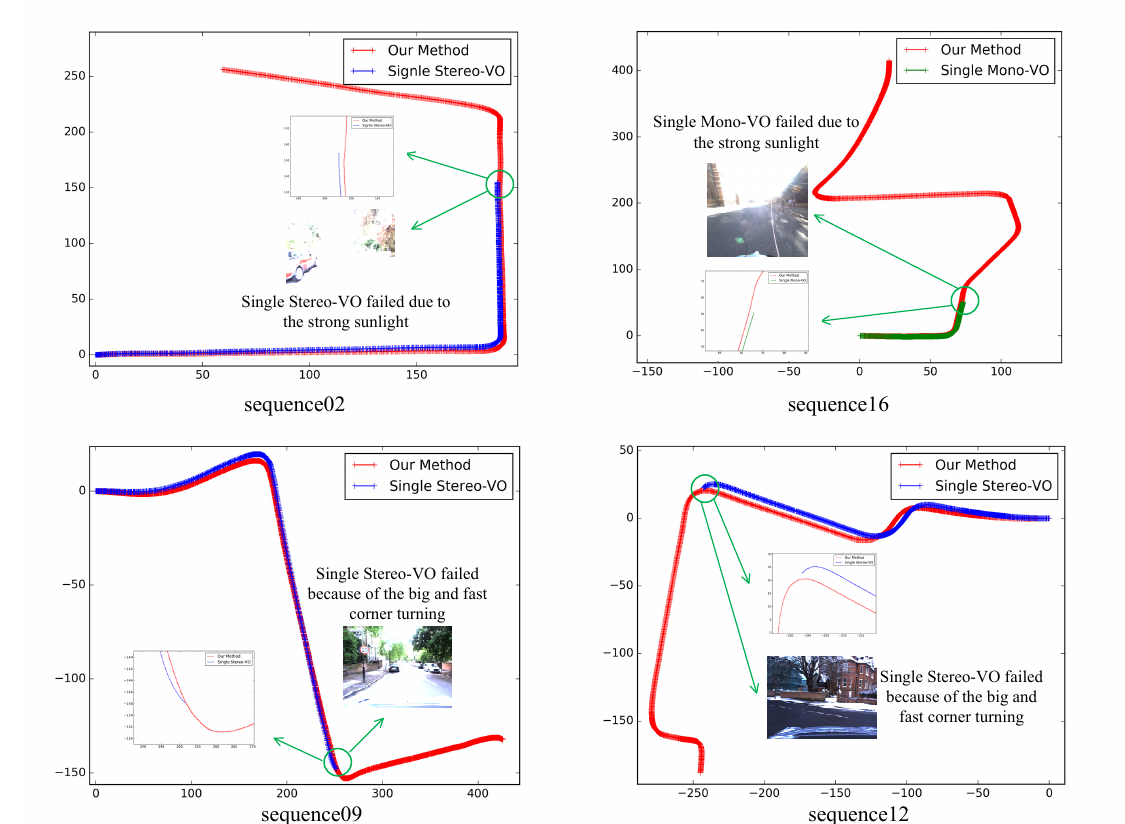
Figure 10. The top two pictures demonstrate that single stereo visual odometry and single monocular visual odometry sometimes might fail in strong sunlight. The bottom two pictures show they might fail at the corner of fast turning. However, our method always kept a good performance for all the testing sequences. Table 2. Robustness Peformance Comparison of Different Methods in the Oxford Robotcar Dataset. Sequence Duaring Frame DSO DSO ORBSLAM2 OurMethod